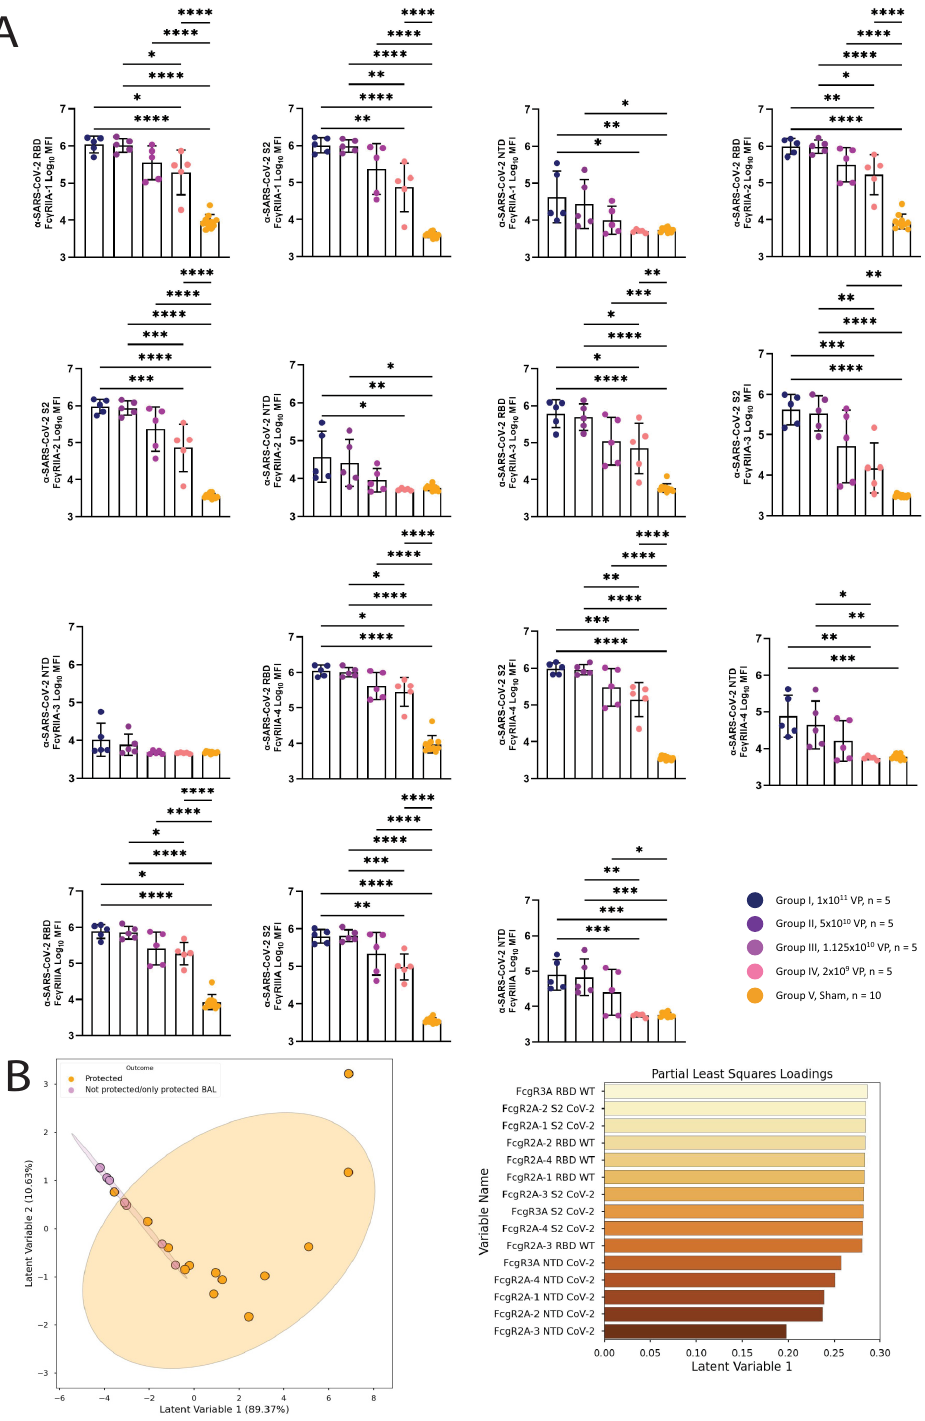
Fig 5. Comparison of Fc γ R binding profiles across SARS-CoV-2 spike domains. (A) The titer of anti–SARS-CoV-2 RBD, S2 spike subunit, and NTD spike subunit antibody binding to Fc γ RIIA-1, Fc γ RIIA-2, Fc γ RIIA-3, Fc γ RIIA-4, and Fc γ RIII were profiled using Luminex. (B) Scores plot (upper plot) and loadings along the first latent variable (lower plot) for a PLS-R model, regressing on the AUC of viral load as measured by BAL over a 10-day time course. Each point represents an NHP, either completely protected (orange) or lacking complete protection (purple);